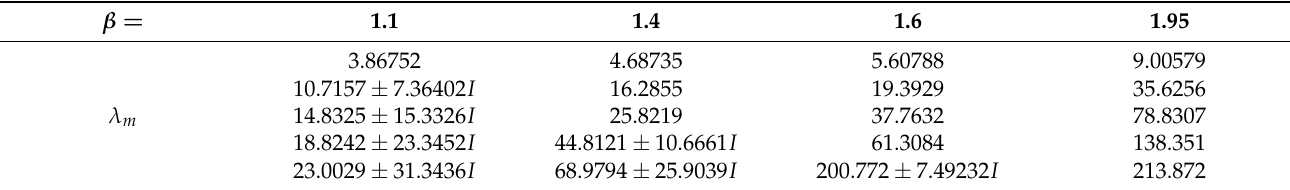
Table 1. The first five real and complex eigen values of Equation (10) at different β . β =